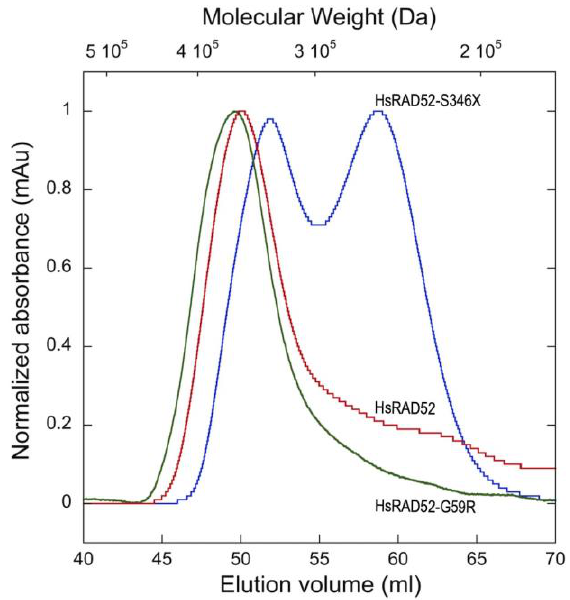
FIGURE 5: HsRAD52-S346X alters the in-solution oligomerization state of HsRAD52 . Superdex 200 size exclusion elution profiles are shown for HsRAD52 1-212, HsRAD52-G59R 1-212 , and HsRAD52- S346X. HsRAD52 1-212 (red trace) eluted as a single peak at 50.0ml, with an estimated size of 360kDa. HsRAD52-G59R 1-212 (green trace) eluted as a single peak at 49.6 ml with an estimated size of 366kDa. HsRAD52-S346X (blue trace) eluted as two peaks; the first peak eluted at 51.9 ml with an estimated size of 335kDa, and the second peak eluted at 58.7ml with an estimated size of 257kDa. (mAU = milliabsorbance